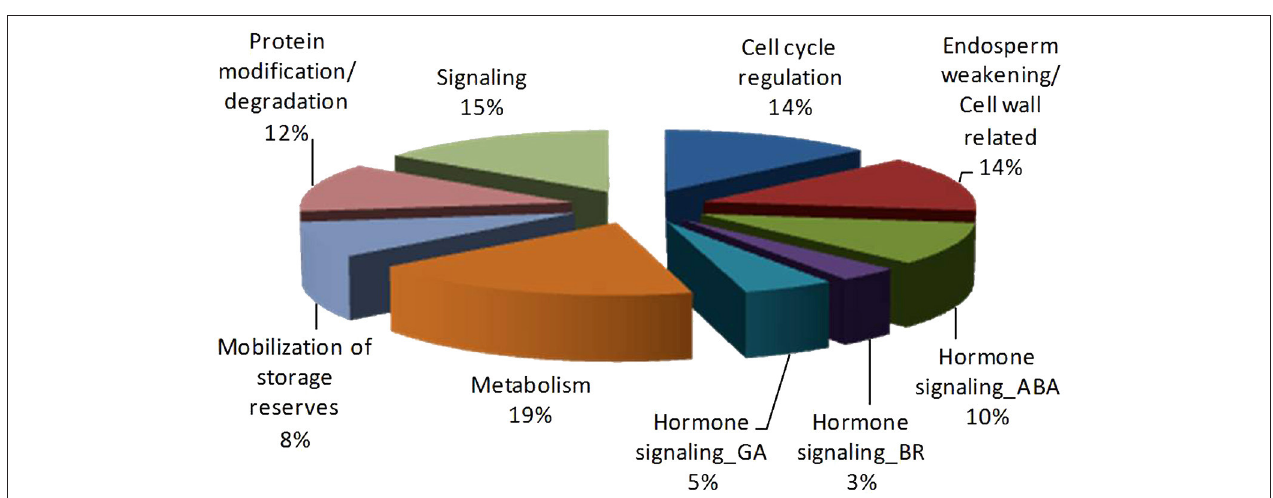
FIGURE 7 | Pie-chart representing germination relevant Key proteins identified from Podophyllum Germination interactome analysis. Functional categorization of 60 central proteins of PGN.